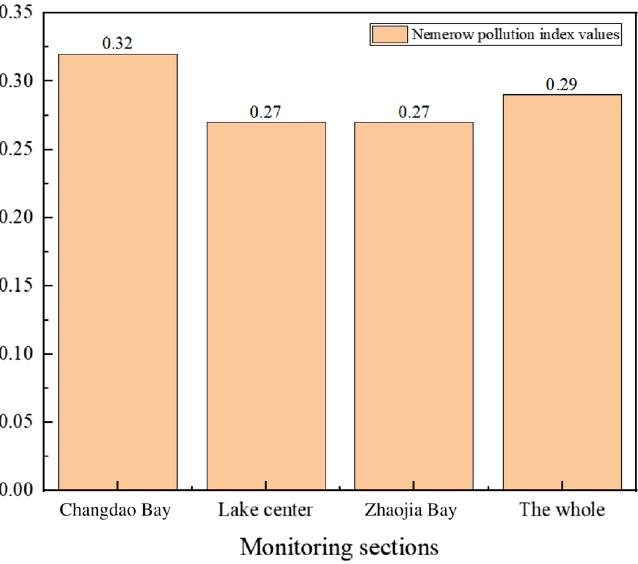
Figure 3. Comparison of Nemerow pollution index of various monitoring sections of Lugu Lake in 2019.